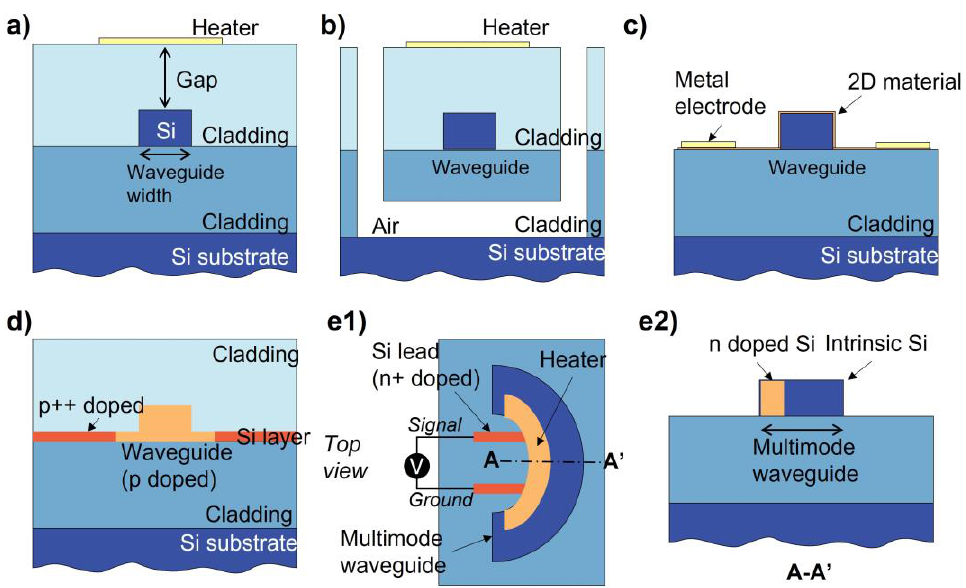
Figure 6. Various structures of thermo-optics phase shifters. ( a ) Traditional thermo-optics phase shifter, ( b ) thermo-optics phase shifter with air trench, ( c ) thermo-optics phase shifter with 2D material heaters, ( d ) thermo-optics phase shifter with doping silicon heater, ( e1 ) bended thermo-optics phase shifter with doping silicon heater and ( e2 ) its cross-sectional schematic.